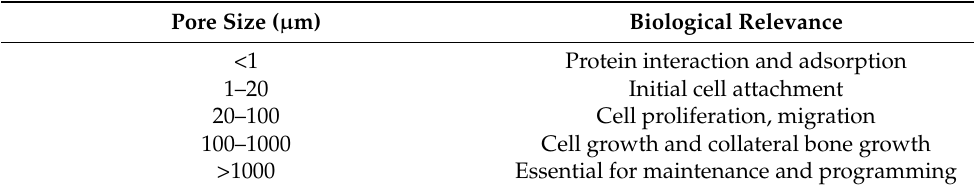
Table 2. Pore size distribution for an ideal scaffold in bone tissue engineering